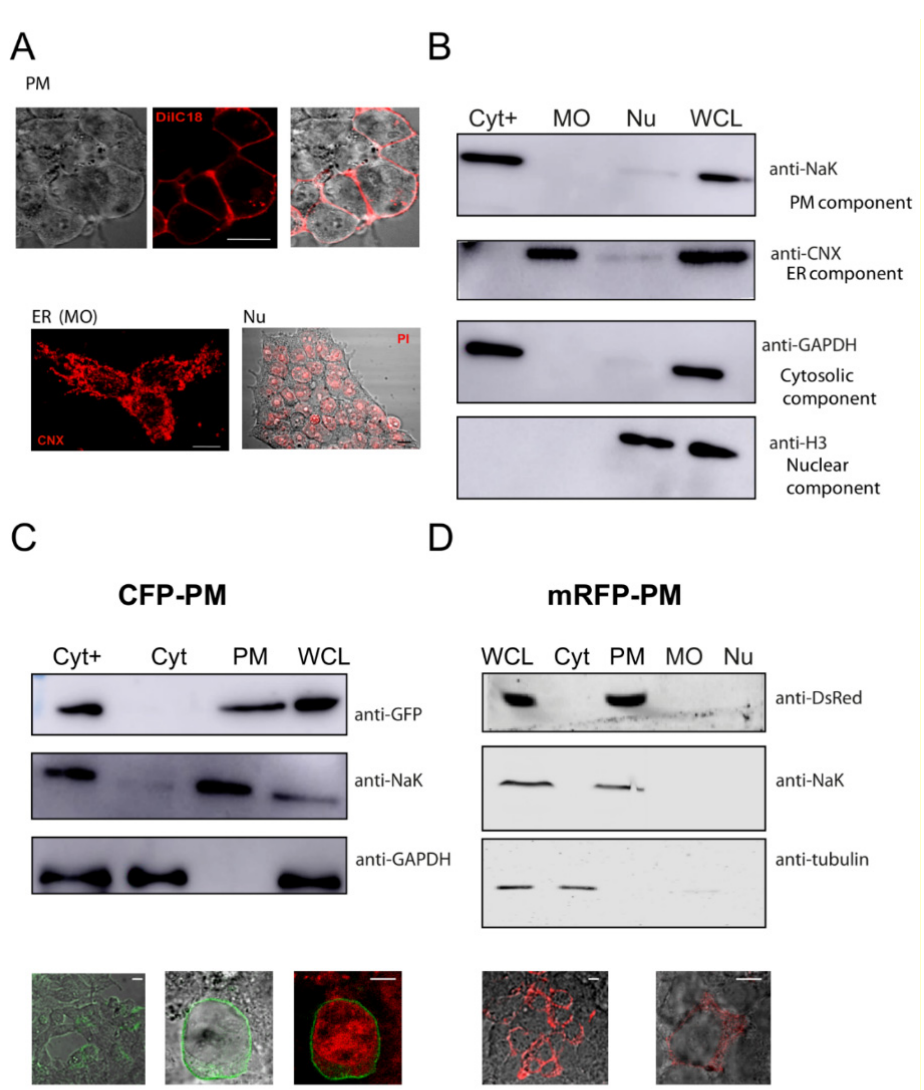
Figure 2. Extraction of proteins from different cell compartments. ( A ) Fluorescent microscopy images of the HEK293 cells used showing the labeling of the plasma membrane (top panel) with DiIC18